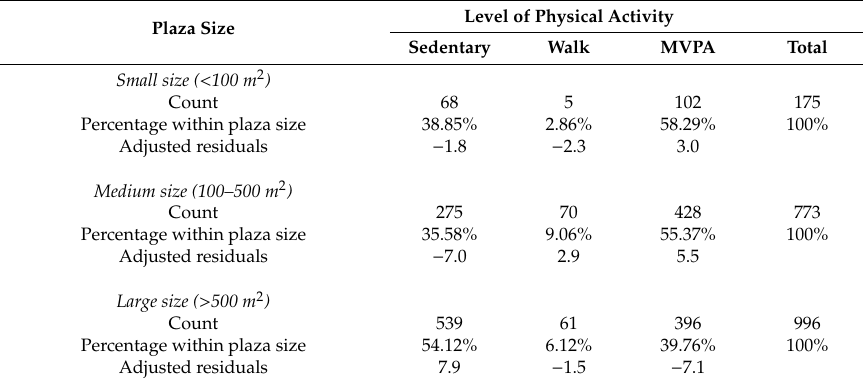
Table 6. Cross tabulation of plaza size and level of physical activity.